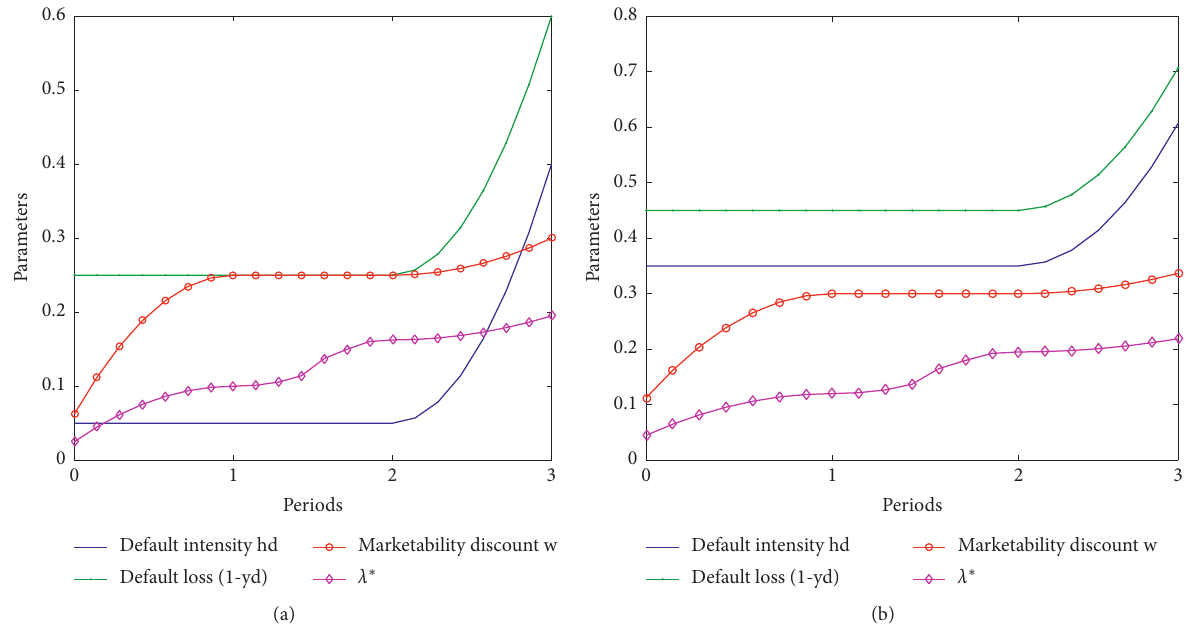
Figure 4: Parameter settings for liquidity-leading crisis (investment-grade/speculative-grade bond).